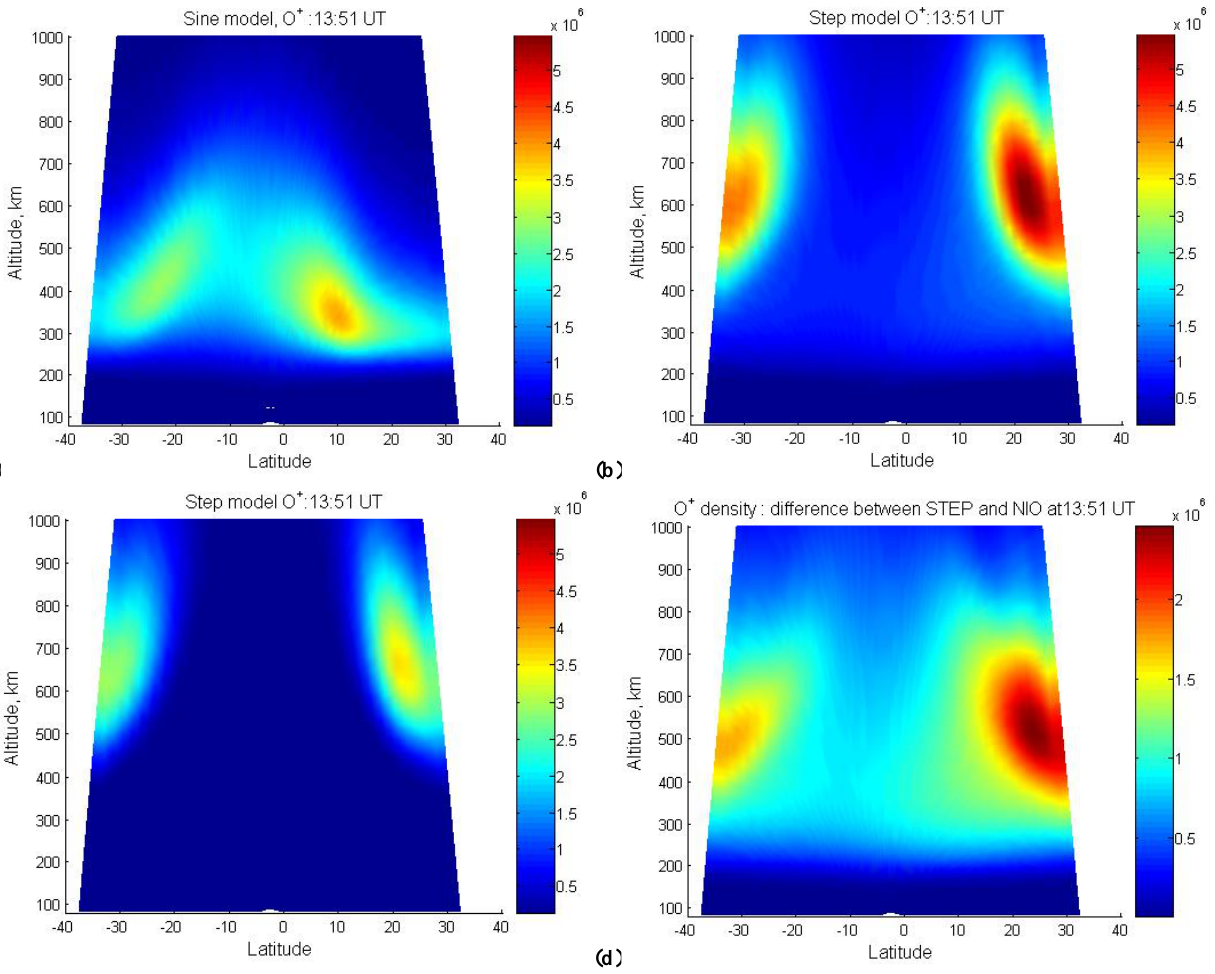
Fig. 1. Modeling of O + ion uplift during strong IEF events/magnetic storms. The color insets on the right of each panel show the local ion density in cm − 3 . The following models of E × B drift were used: a “sine” wave background model (a) , a PPEF step model (b) , and the step model without solar photoionization (c) . All density profiles are shown for ∼ 02:00 p.m. local time. Differences in the ion density between the step model with and without ionization is also shown (d) . Notice the maximum difference occurs at ∼ 500km and for ∼ 25 ◦ latitude. Figure 1. Modeling of O + ion uplift during strong IEF events/magnetic storms. The color above 350 km to almost 900 km in the latitude range of 20 ◦ insets on the right of each panel show the local ion density in cm -3 . The following models of E Figure 1. Modeling of O + ion uplift during strong IEF events/magnetic storms. The color to 35 ◦ geographical latitude. This result is generally consis- Figure 1. Modeling of O + ion uplift during strong IEF events/magnetic storms. The color tent with the observed uplift of O + at DMSP satellite alti- x B drift were used: a “sine” wave background model (a), a PPEF step model (b), and the step insets on the right of each panel show the local ion density in cm -3 . The following models of E Figure 1. Modeling of O + ion uplift during strong IEF events/magnetic storms. The color insets on the right of each panel show the local ion density in cm -3 . The following models of E tudes ( ∼ 840 km) (Tsurutani et al., 2006). However detailed model without solar photoionization (c). All density profiles are shown for ~ 2 pm local time. x B drift were used: a “sine” wave background model (a), a PPEF step model (b), and the step modeling will be necessary to match the DMSP ion temporal insets on the right of each panel show the local ion density in cm -3 . The following models of E x B drift were used: a “sine” wave background model (a), a PPEF step model (b), and the step variations and local time ( ∼ 09:30 a.m.) dependence of the Differences in the ion density between the step model with and without ionization is also model without solar photoionization (c). All density profiles are shown for ~ 2 pm local time. x B drift were used: a “sine” wave background model (a), a PPEF step model (b), and the step model without solar photoionization (c). All density profiles are shown for ~ 2 pm local time. Differences in the ion density between the step model with and without ionization is also shown (d). Notice the maximum difference occurs at ~ 500 km and for ~ 25° latitude. model without solar photoionization (c). All density profiles are shown for ~ 2 pm local time. Differences in the ion density between the step model with and without ionization is also shown (d). Notice the maximum difference occurs at ~ 500 km and for ~ 25° latitude. Differences in the ion density between the step model with and without ionization is also shown (d). Notice the maximum difference occurs at ~ 500 km and for ~ 25° latitude. shown (d). Notice the maximum difference occurs at ~ 500 km and for ~ 25° latitude.